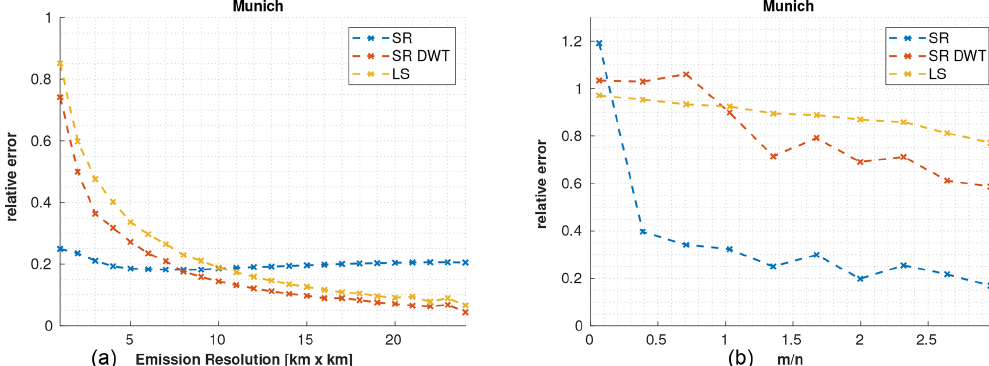
Figure 10. Reconstruction errors use SR in the spatial and wavelet domain as well as the LS for Munich with an SNR of 20dB, where (a) shows the average relative error for the reconstruction of 250 different noise vectors at different levels of resolutions using m/n ≈ 1 . 5 and (b) shows the relative error for the highest resolution (1km × 1km) when varying the number of measurements.